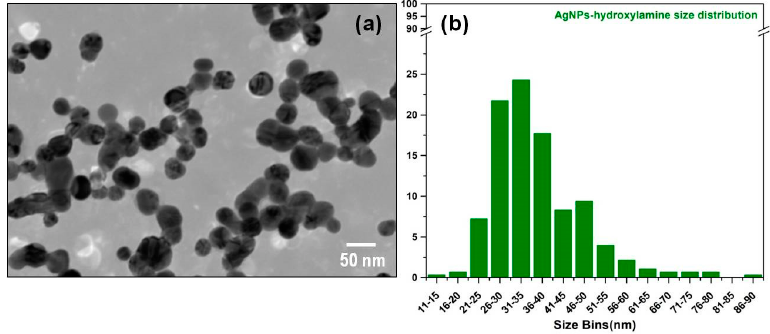
Figure 2. Transmission Electron Microscopy (TEM) image of the silver nanoparticles ( a ). Statistical analysis of nanoparticles diameters obtained from TEM images ( b ).